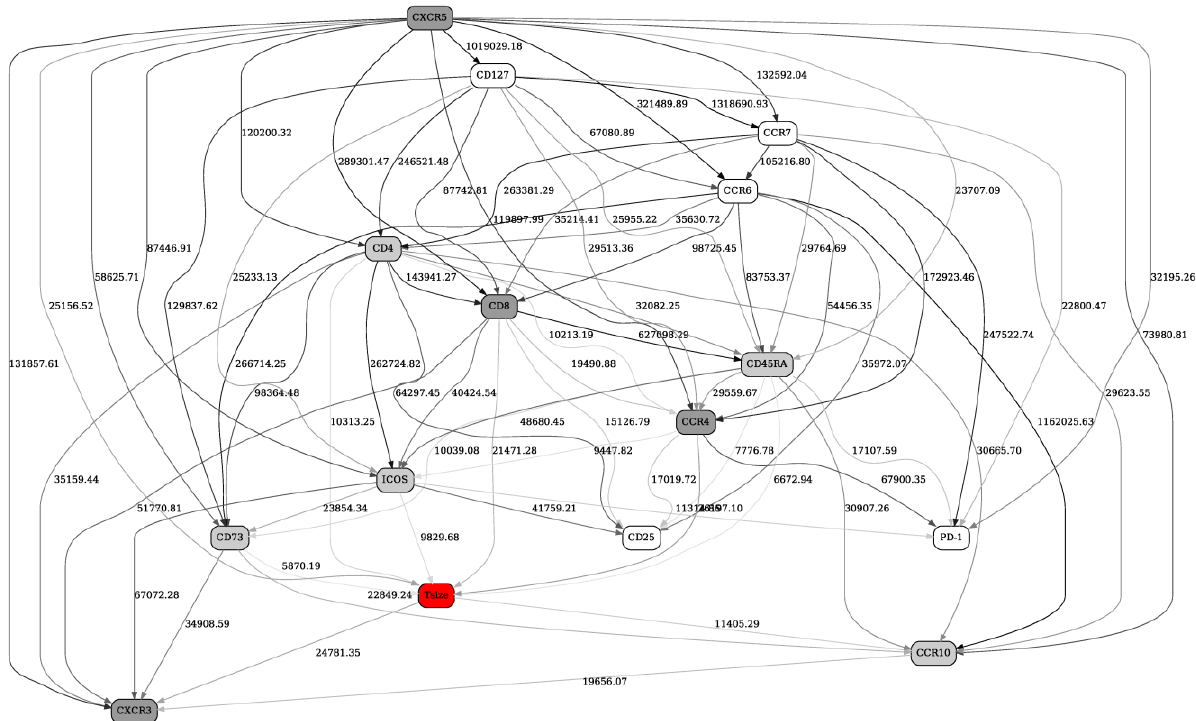
Figure 3. A full BN constructed from FACS data (Adaptive panel) from 13 patients preimmunotherapy treatment (day 1). See Figure 1 legend for further details.